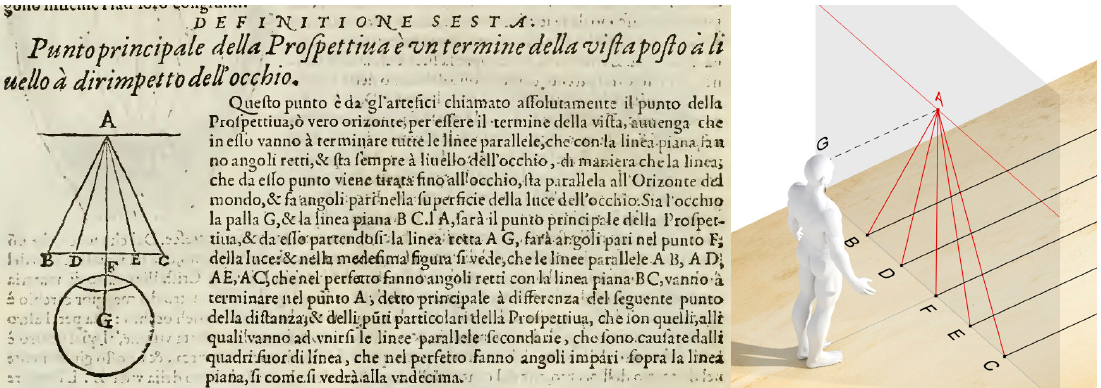
Figure 1. Example of a definition in the first part of the Treaty. In this definition, Vignola illustrates the principle point as the point in which the perspectives of the lines perpendicular to the picture plane converge.